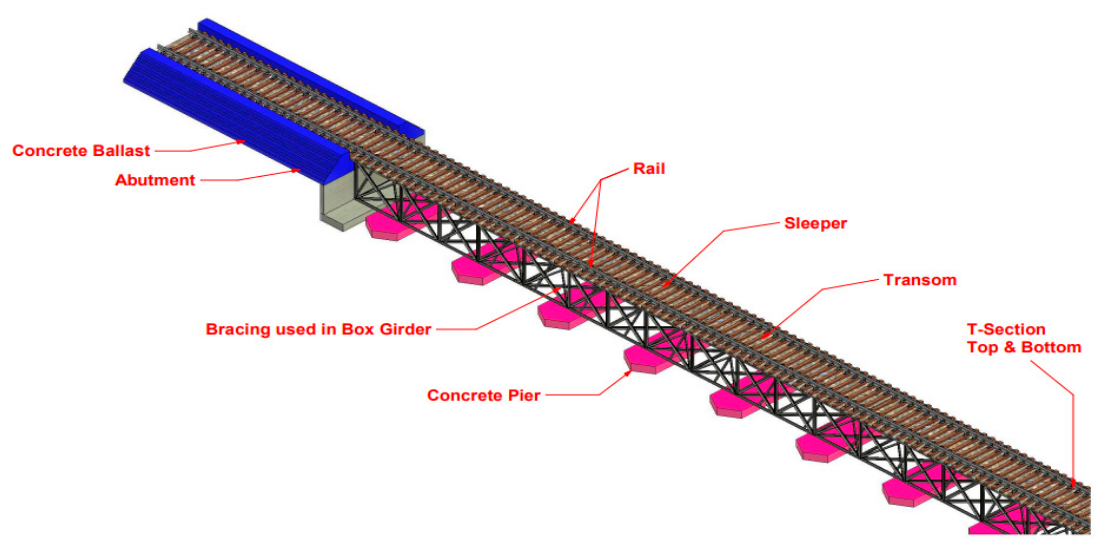
Figure 3. A 3D model of the Minnamurra Railway Bridge developed using AutoCAD Revit v 2022.